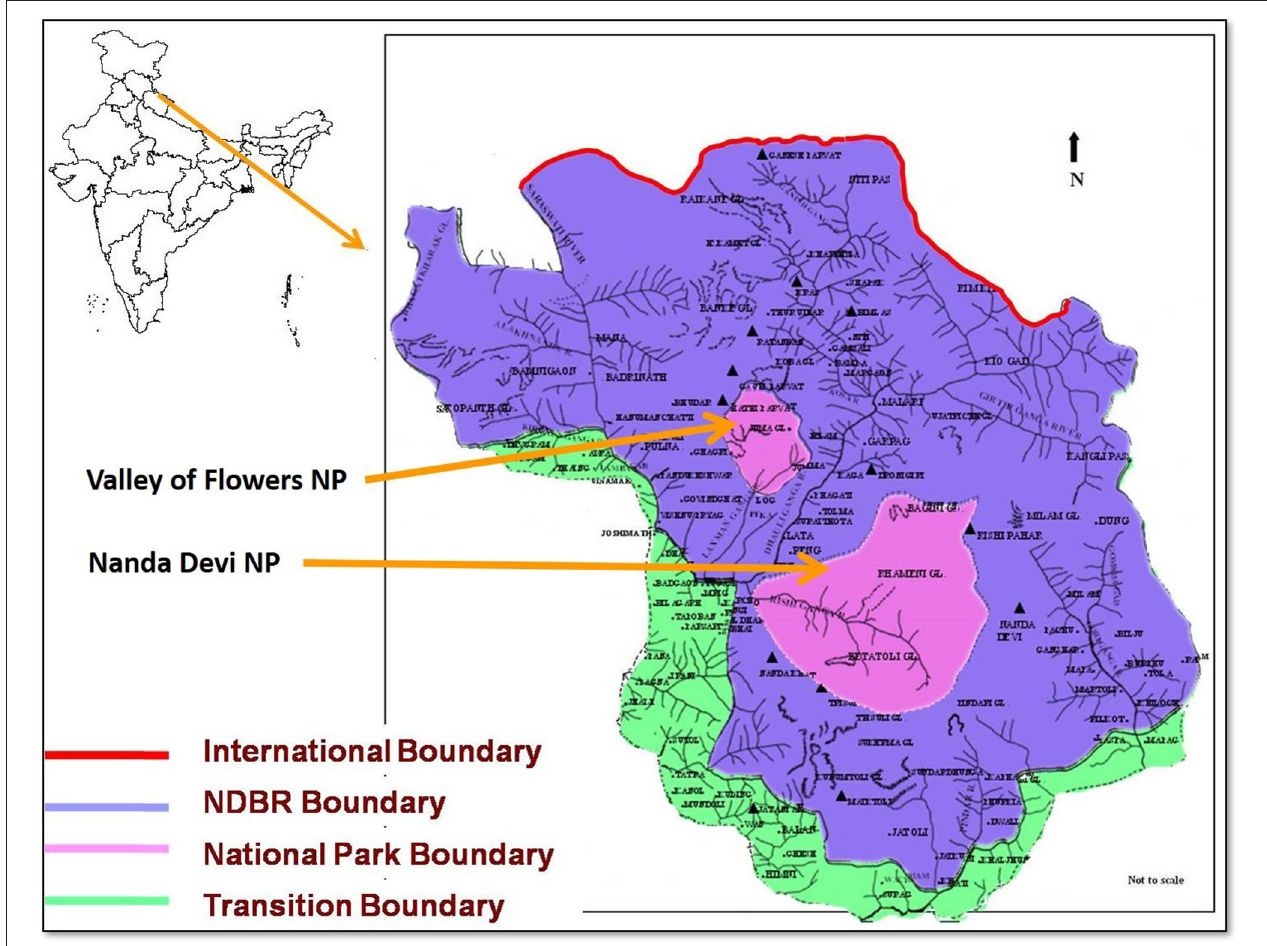
FIGURE 1 | Location map and administration zones of the Nanda Devi Biosphere